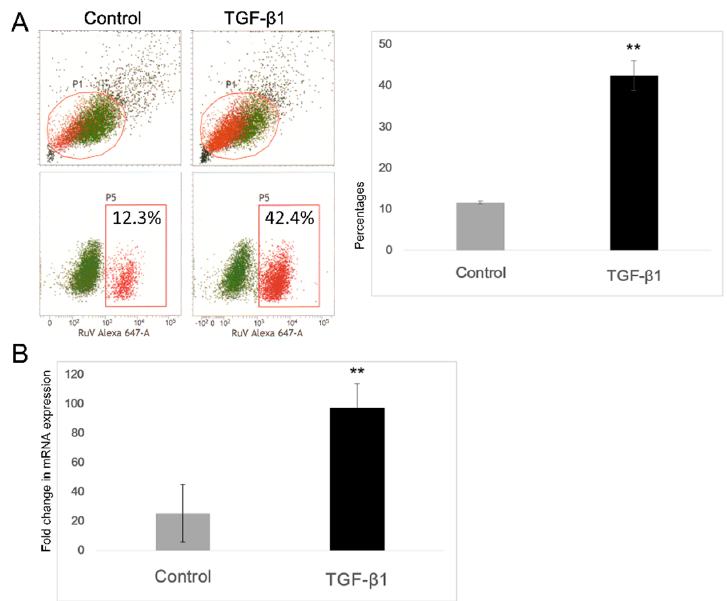
Figure 4. Virus binding assay showed an enhancement in rubella virus binding to the TGF- β -treated A549 cells. After TGF- β 1 treatment, the cells were inoculated with RuV at an MOI of 5 on ice for 1 h. After washing, the surface staining procedures for RuV were conducted, and the cells were